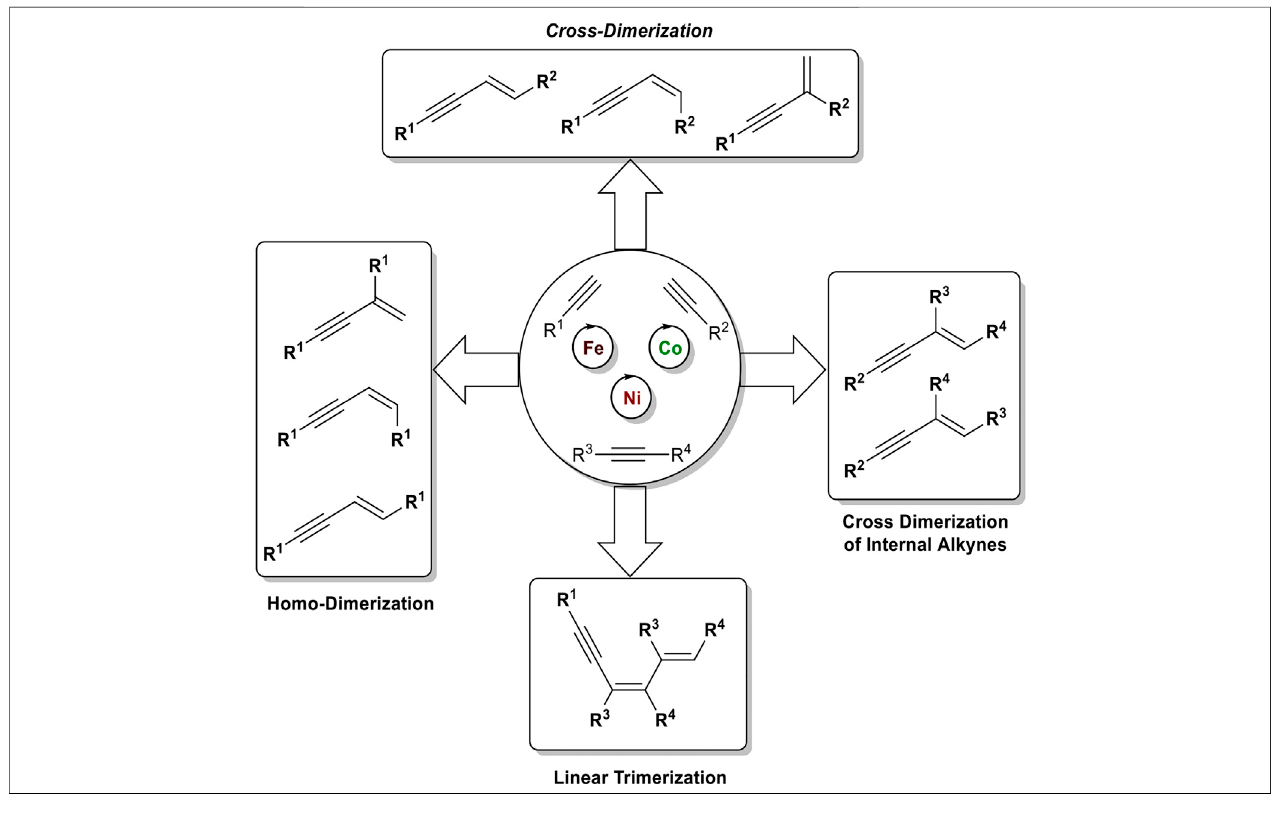
FIGURE 1 | Selected examples of naturally occurring 1,3-enynes and synthetic drugs, which incorporate an 1,3-enyne motif.